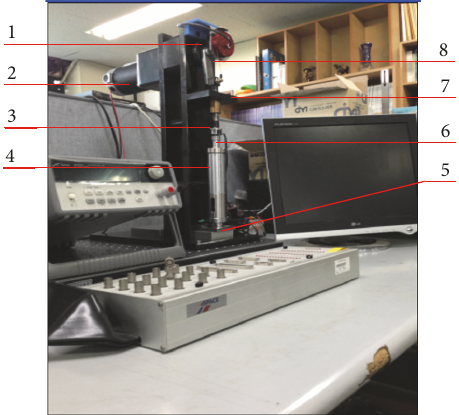
Figure 6: Experimental apparatus for building the dataset for training the